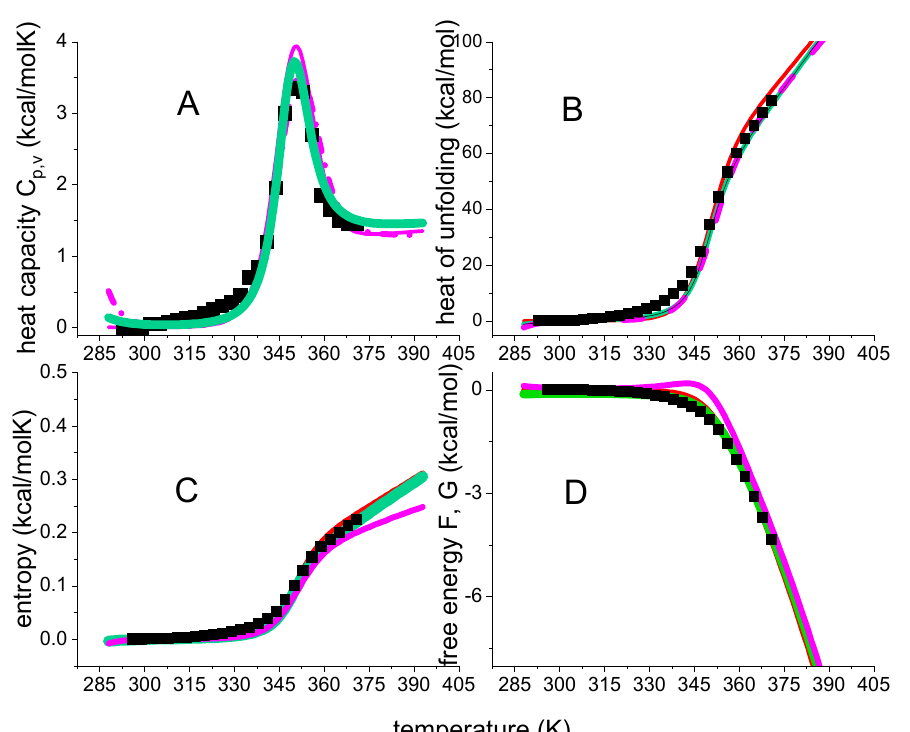
Figure 8. DSC of β -lactoglobulin in 0.1 M KCl/HCl, pH 2.0 buffer. Black data points in panel A are taken from reference [39] (Figure 1). Magenta lines: Θ U (T)-weighted chemical equilibrium two-state model ( ∆ H 0 = 50 kcal/mol, ∆ C 0 p = 1.3 kcal/molK). Red lines: statistical-mechanical two-state model ( ∆ E 0 = 55 kcal/mol, C v = 0.6 kcal/molK) Green lines: multistate cooperative model (h 0 = 380 cal/mol, c v = 3 cal/molK, σ = 7 × 10 − 5 , N = 160). ( A ) Heat capacity. ( B ) Unfolding enthalpy. ( C ) Unfolding entropy). ( D ) Free energy of unfolding.